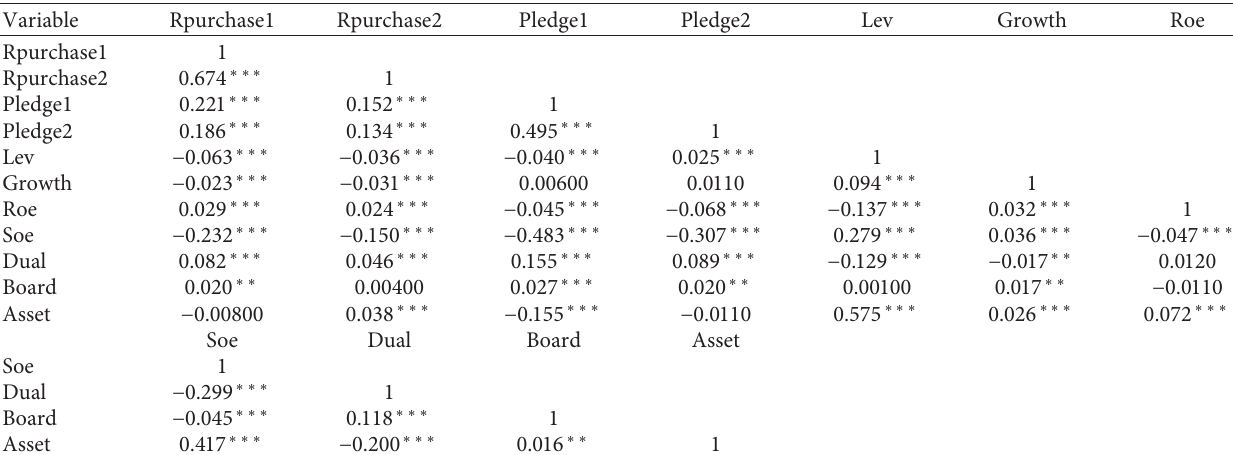
Table 3: Correlation